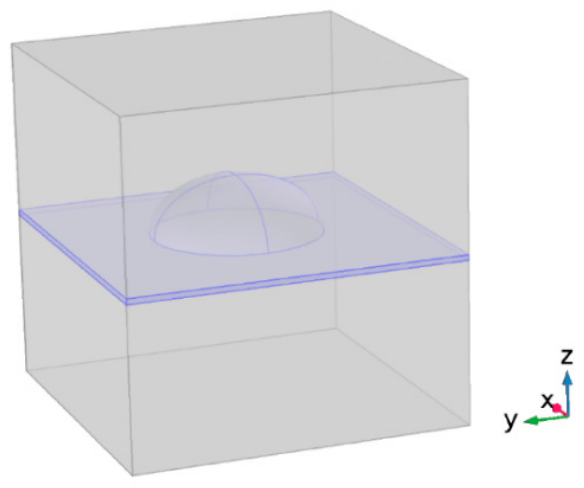
Figure 1. Schematic illustration of the investigated dome shaped quantum dot (QD) .